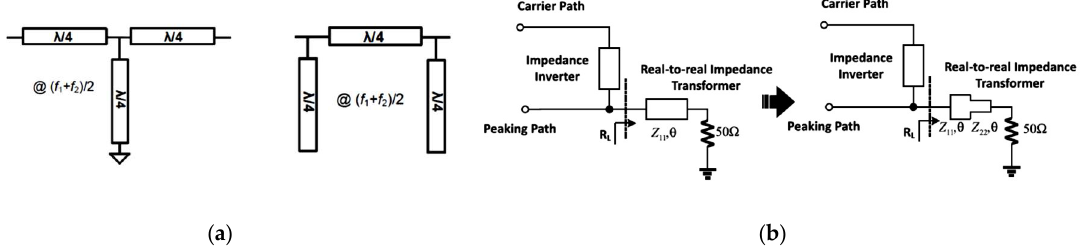
Figure 20. ( a ) Dual-band quarter-wave impedance inverter, T-network and π -network [115]. ( b ) A real-to-real impedance transformer is used to transform the output load to the required resistance at the Doherty common node: single-band and to dual-band [117].